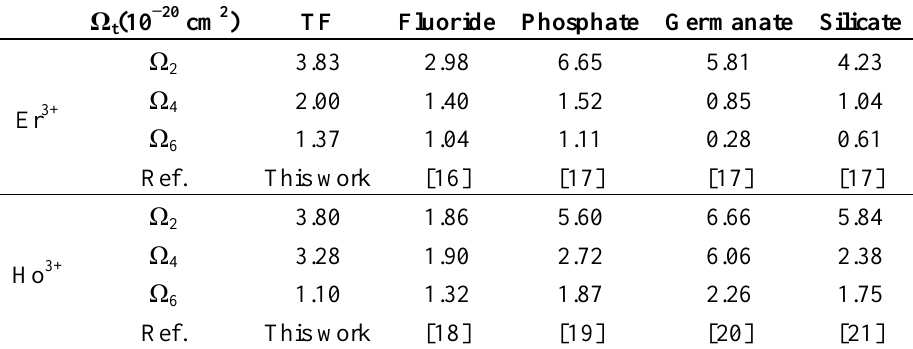
Table 2. Judd–Ofelt intensity parameters of Er 3+ and Ho 3+ in various glasses.